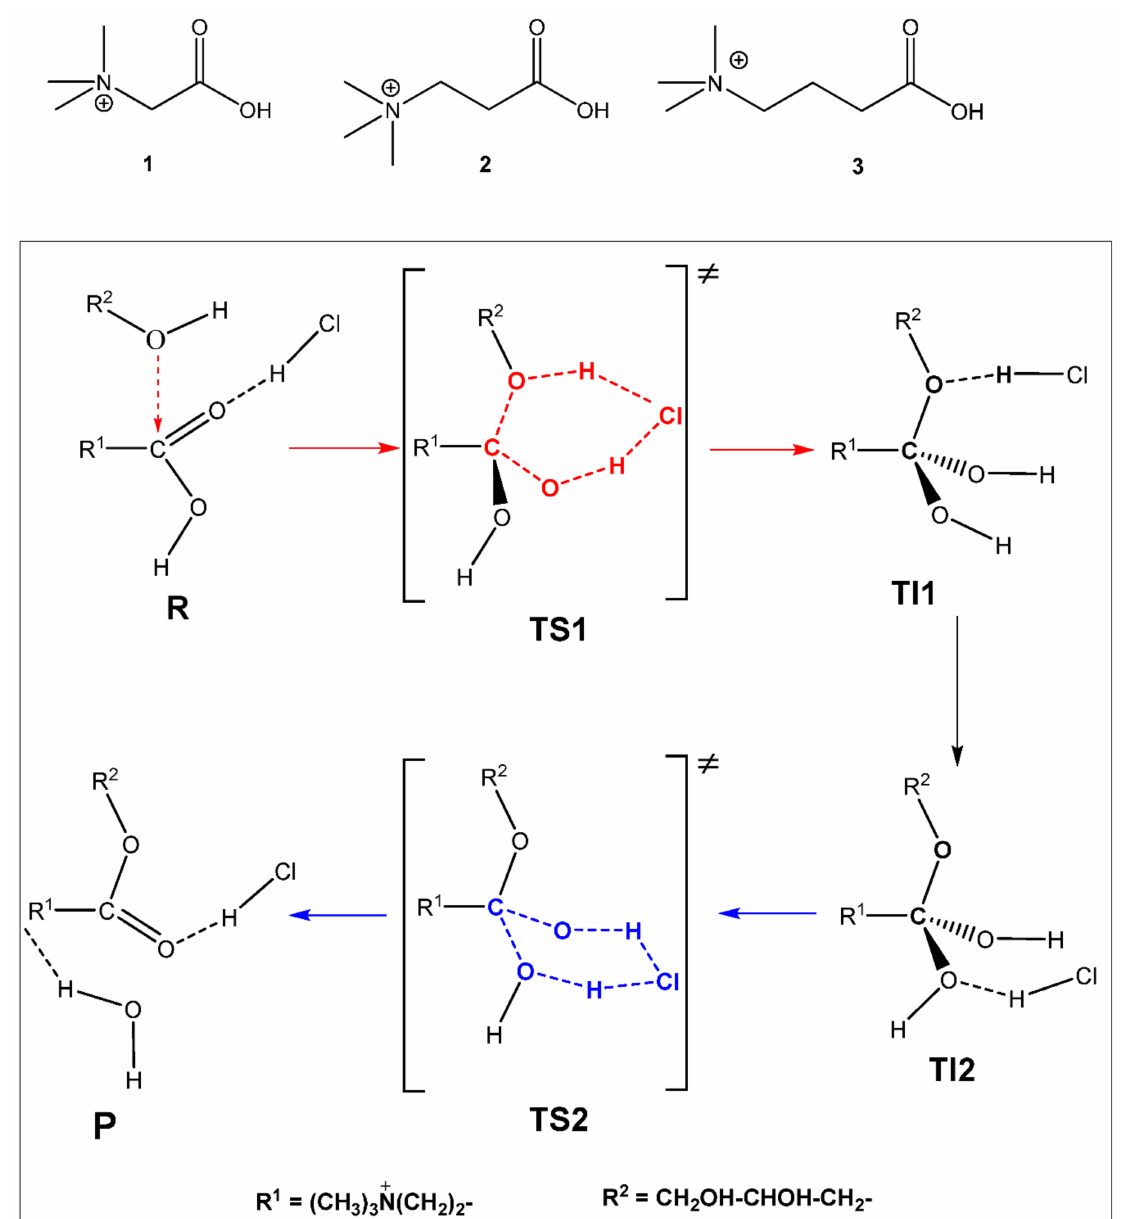
Figure 1. Structure of protonated betaines 1 ( top left ), 2 ( top middle ) and 3 ( top right ) and Bachmann–Frapper mechanism of esterification ( bottom